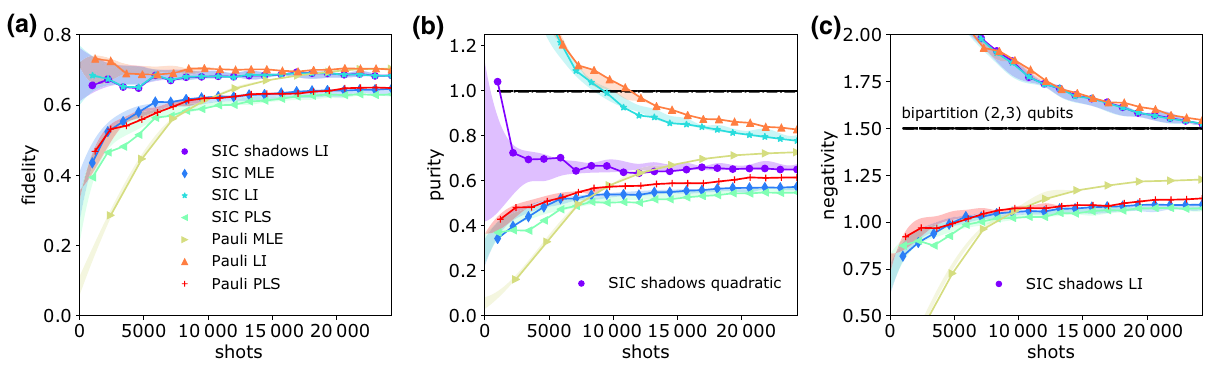
FIG. 7. Comparison between SIC and Pauli tomography for a standard set of reconstruction methods. Using the five-qubit AME state from Fig. 4 in the main text, we analyze fidelity, purity, and negativity from Eq. (A1). Because of the increased experimental complexity, we observe that SIC methods generally converge to slightly lower values than Pauli; however, this is not inherent to the method, but rather the implementation. (a) Fidelity converges quickest for LI approaches, as expected for general linear functions; see Appendix A 10. Convergence of PLS, however, is very slow compared to all other methods. SIC MLE at low shot numbers performs better than Pauli MLE as SIC measurements provide the maximum information gain. (b) SIC-based classical shadows (“SIC shadows quadratic”) demonstrate the best convergence for purity. MLE methods converge similarly to (a), but LI methods show very slow convergence with highly unphysical results, making their use problematic in practice. (c) As a commonly used entanglement measure, we evaluate the negativity of the reconstructed states; see the text for details. As expected, this property converges the slowest, since it is a global property of the density matrix (making this nonscalable), with LI again showing highly unphysical results. Bright shaded regions represent 1 standard deviation around the mean value when averaging multiple sets at the given shot number. Black horizontal lines denote ideal